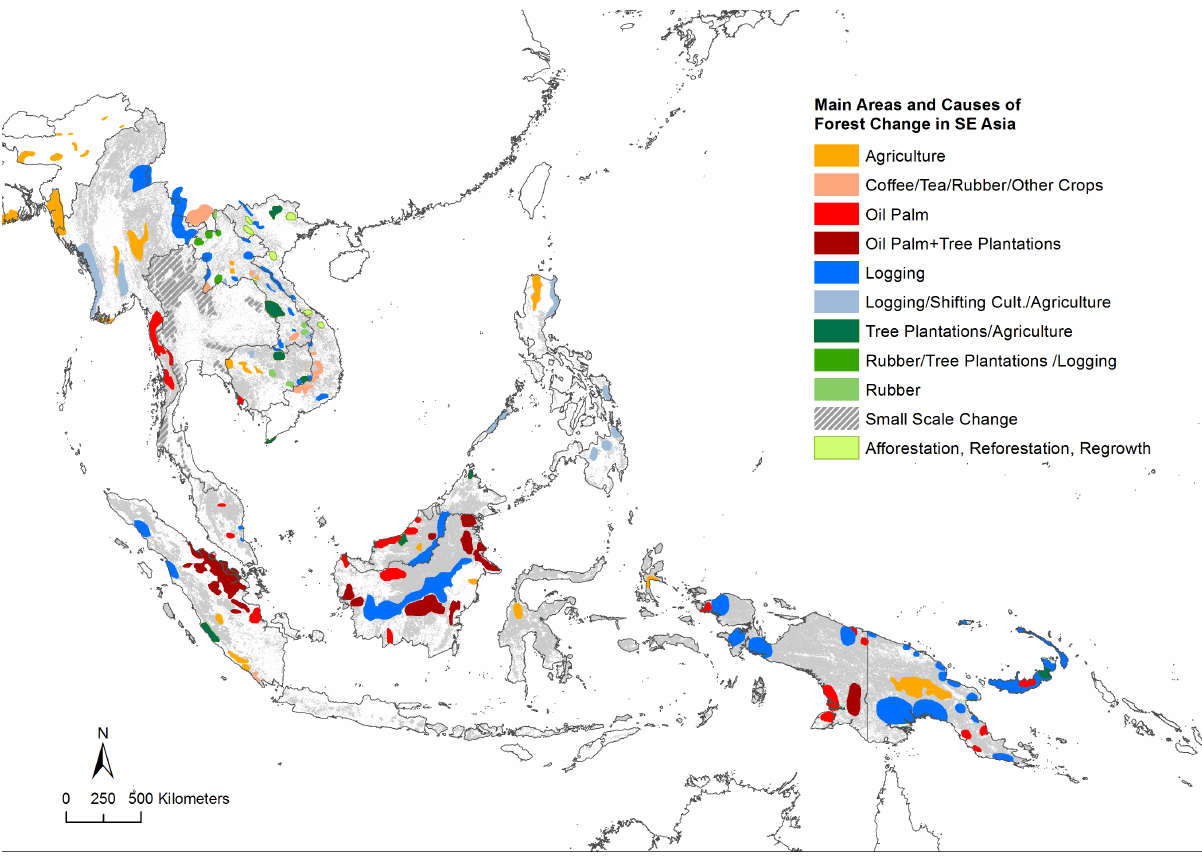
Fig. 7. Regional pattern of main areas and causes of forest change in Southeast Asia, as identified by expert consultation. Background map (grey): Forest Cover